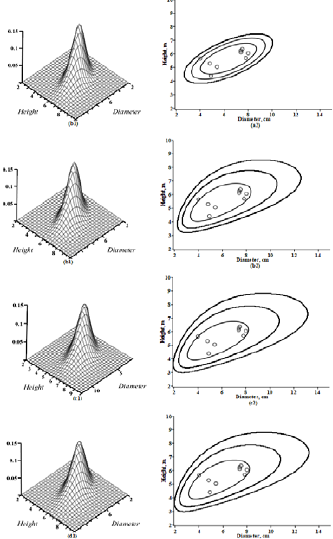
Figure 1. Bivariate probability density functions and their contour plots for a particular randomly selected stand from the validation dataset: ( a1,b1,c1,d1 ) mixed-effect bivariate densities, ( a2,b2,c2, d2 ) Contour plots (levels: 5 − 2 , 5 − 3 , 5 − 4 ), ( a1,a2 ) Vasicek type, ( b1,b2 ) Gompertz type, ( c1,c2 ) Bertalanffy type, and ( d1,d2 ) Gamma type. Values observed from the validation dataset are represented by circles. For mountain pine trees, the height and diameter probability density function presented steeper and more symmetrical surfaces for the Vasicek-type diffusions (see Figure 1); however, with increasing age, the surfaces became flatter.